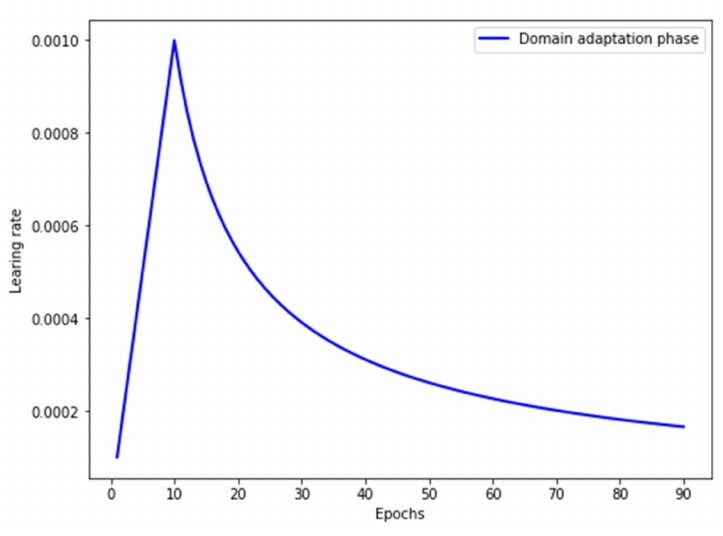
Figure 4. Learning rate of domain adaptation